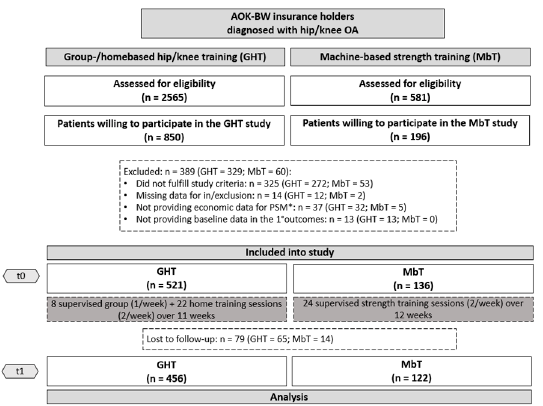
Figure 1. Flowchart. *PSM = Propensity score matching. Economic analyses will be pub- lished